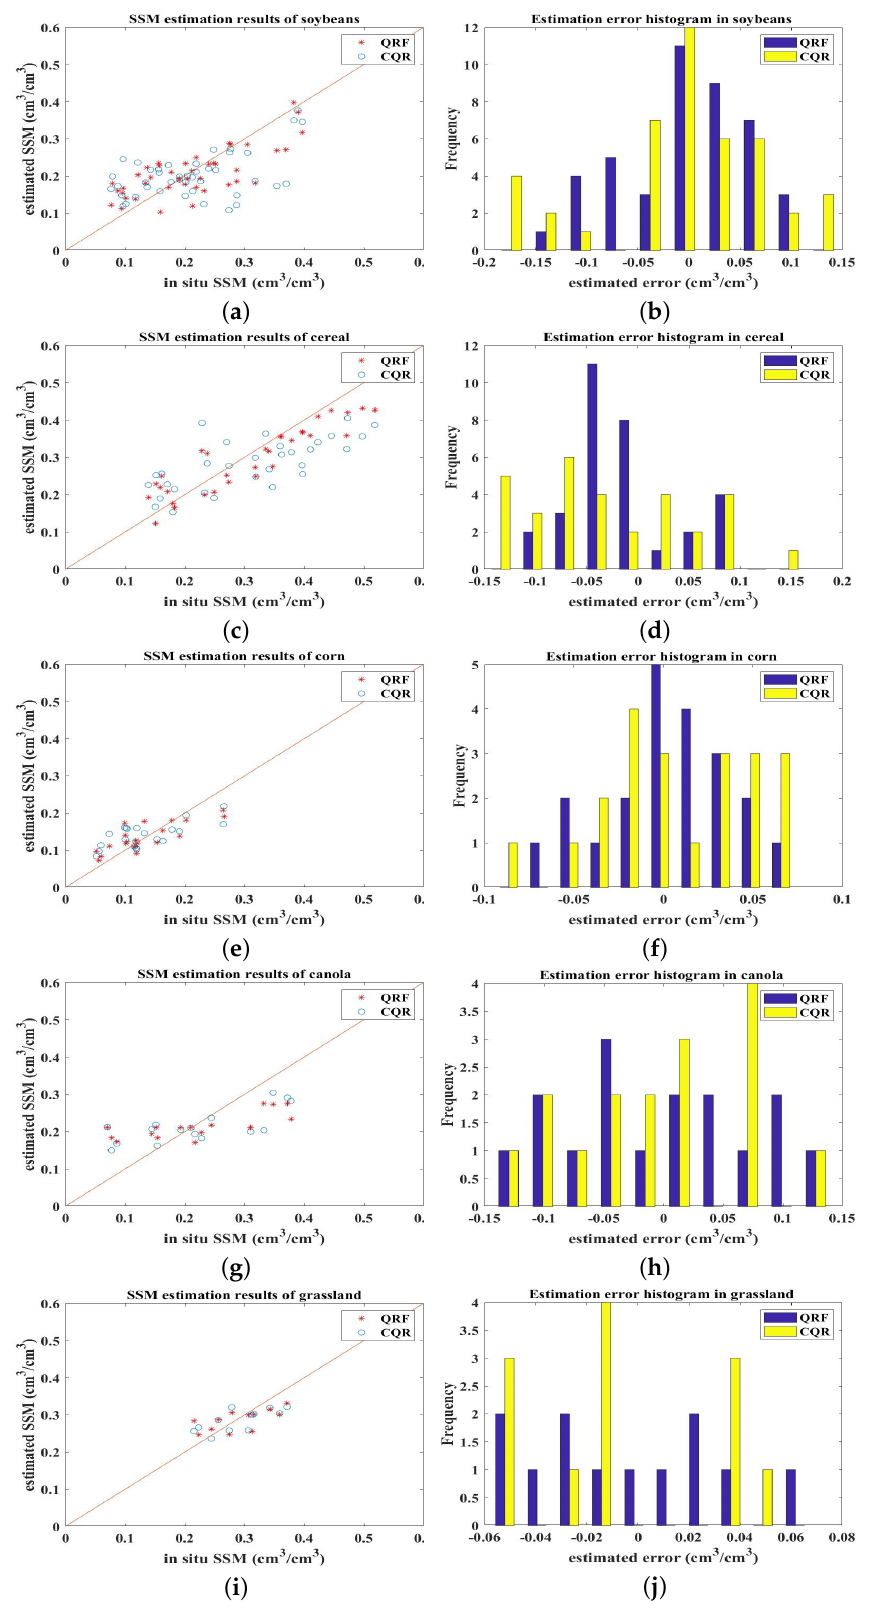
Figure 5. Scatter plot and error histogram of the estimated and in situ SSM. ( a ) Scatter plot of soybeans; ( b ) Error histogram of soybeans; ( c ) Scatter plot of cereal; ( d ) Error histogram of cereal; ( e ) Scatter plot of corn; ( f ) Error histogram of corn; ( g ) Scatter plot of canola; ( h ) Error histogram of canola; ( i ) Scatter plot of grassland; ( j ) Error histogram of